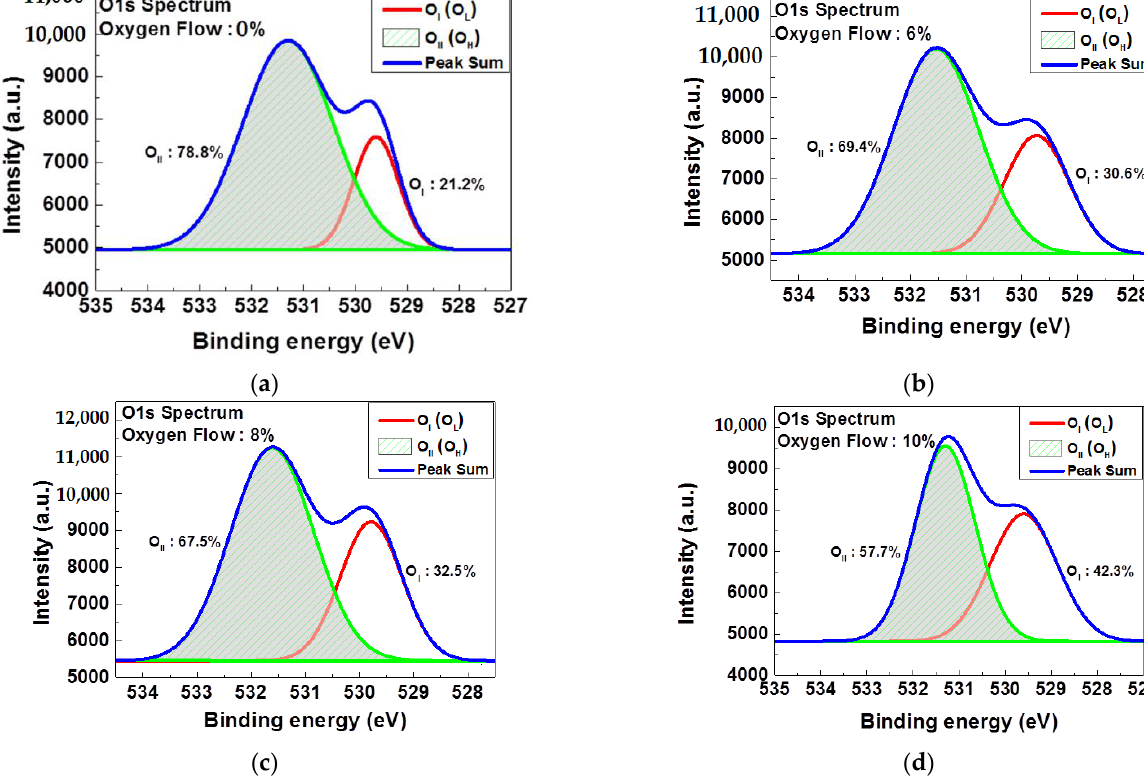
Figure 5. XPS O1s spectra of InTiZnO thin film with various oxygen flow ratios: ( a ) 0%, ( b ) 6%, ( c ) 8%, ( d ) 10%.